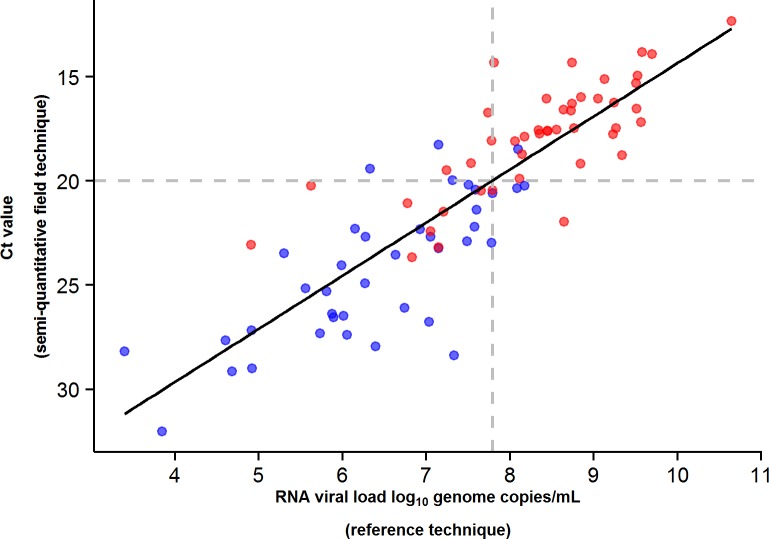
JIKI trial: correlation between EBOV RT-PCR Ct value and RNA viral load at baseline in adolescents and adults.The black line represents the regression line. The Spearman rank correlation coefficient was 0.88 (p < 0.001). A baseline Ct value of 20 corresponded to an RNA viral load of 5 × 107 genome copies/ml of plasma (7.7 log10 copies/ml). Of the 99 adolescents and adults, 84 had both an RT-PCR Ct and an RNA viral load measurement at baseline. Red dots represent patients who died. Blue dots represent patients who survived.